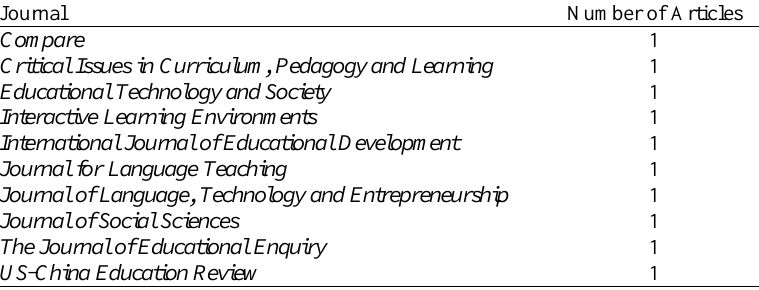
Table 4 International journals in which articles were published derived from doctoral research completed in fields of education in South Africa in